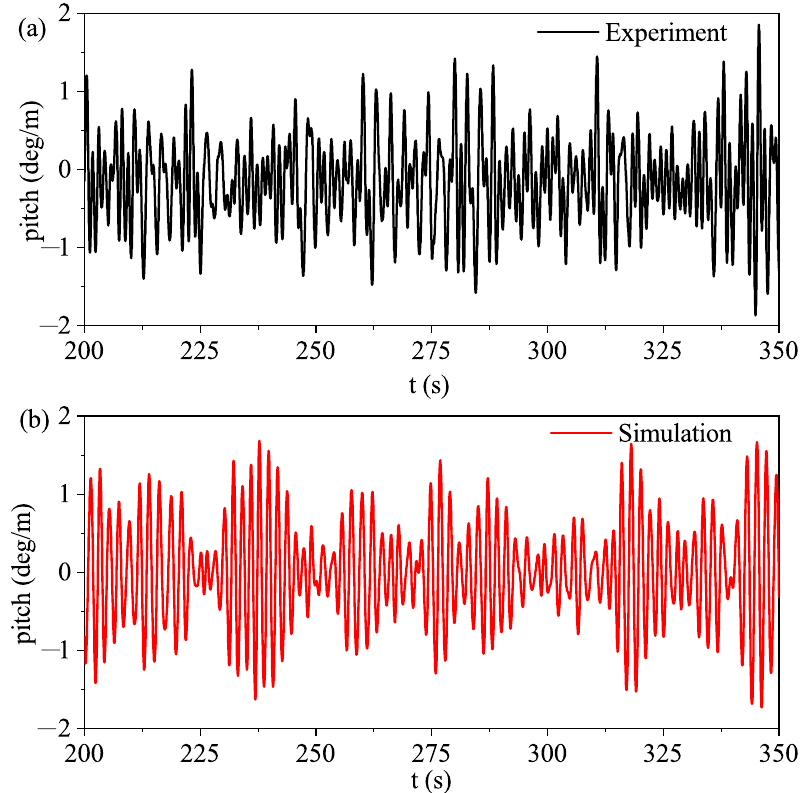
Figure 17. The instantaneous experimental and simulation pitch RAOs: ( a ) pitch motion response from the experimental results; ( b ) pitch motion response from the simulation